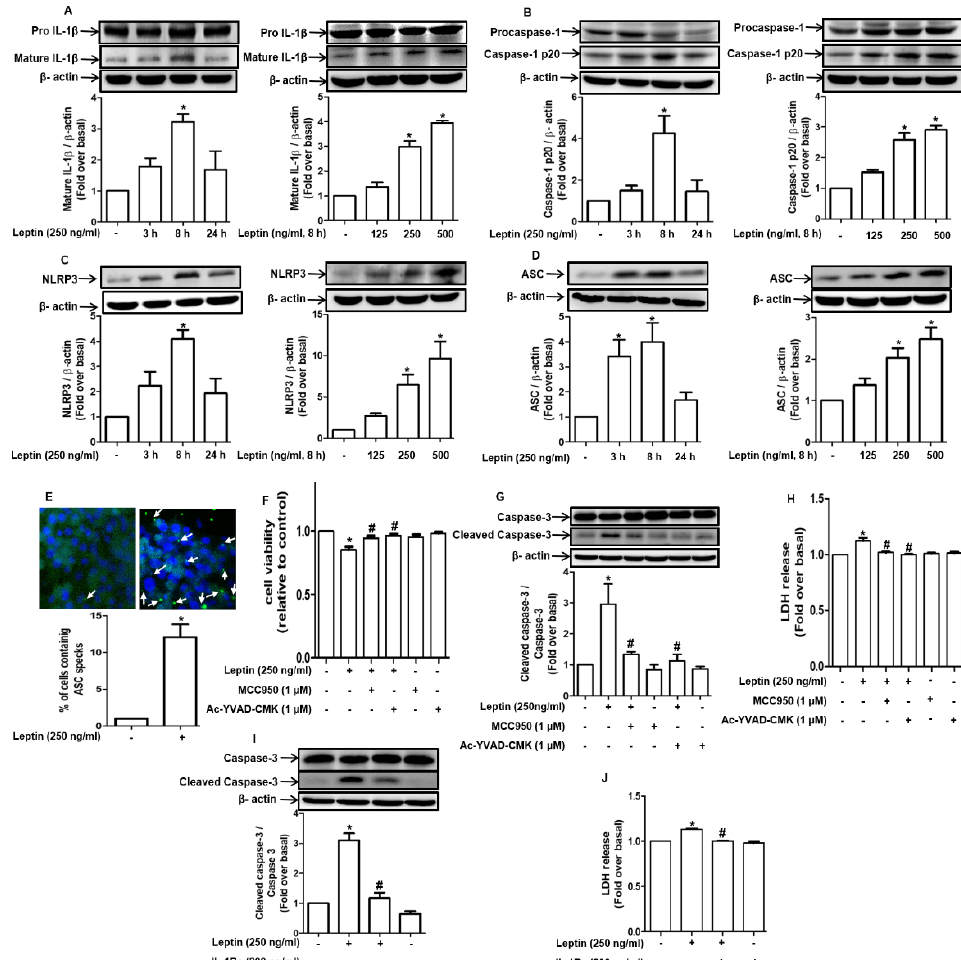
Figure 2. The critical role of inflammasome activation in cytototoxic effects of leptin in rat hepatocytes: ( A – D ) Hepatocytes isolated from rats were incubated with leptin (250 ng/mL) for the indicated time duration or different concentrations of leptin for 8 h. Expression levels of pro- and mature IL-1 β (A), pro- and cleaved caspase-1 ( B ), NLRP3 ( C ), and ASC ( D ) expression levels were determined by Western blot. ( E ) Hepatocytes were treated with leptin (250 ng/mL) for 8 h in collagen-coated chamber slides. ASC speck formation was analyzed by fluorescent immunocytochemistry. Green dots indicated with white arrow and blue color represents ASC speck and DAPI, respectively. Representative images from three independent experiments are presented, and the levels of ASC speck formation were quantified, as shown in the lower panel. ( F – H ) Cells were pretreated with indicated concentrations of MCC950 or Ac-YVAD-CMK, a pharmacological inhibitor of NLRP3 and caspase-1, respectively, for 1 h followed by further incubation with leptin (250 ng/mL) for indicated time duration. ( F ) Cell viability was determined by MTS assay. ( G ) Expression levels of total and cleaved active caspase-3 were determined by Western blot. ( H ) Cell culture media were collected and used to measure the released LDH. ( I , J ) Rat hepatocytes were pretreated with IL-1 receptor antagonist (200 ng/mL) for 1 h followed by further stimulation with leptin for an additional 8 h. ( I ) Total and cleaved active caspase-3 levels were determined by Western blot. ( J ) The levels of LDH in the media were measured. For Western blot analyses, expression levels of the target genes were quantitated by densitometric analysis and are presented in the lower panel of each image. Values are presented as fold changes compared to the control group and are expressed as mean ± SEM, n = 3. In all of the the experiments, * denotes p < 0.05 compared to the control cells; # denotes p < 0.05 compared to the cells treated with leptin